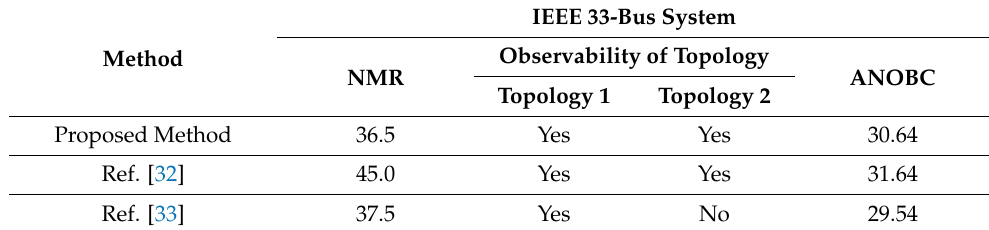
Table 2. Comparison of the minimum number of D-PMUs for complete observability. Table 3. Comparison of multiple indicators of IEEE 33-bus